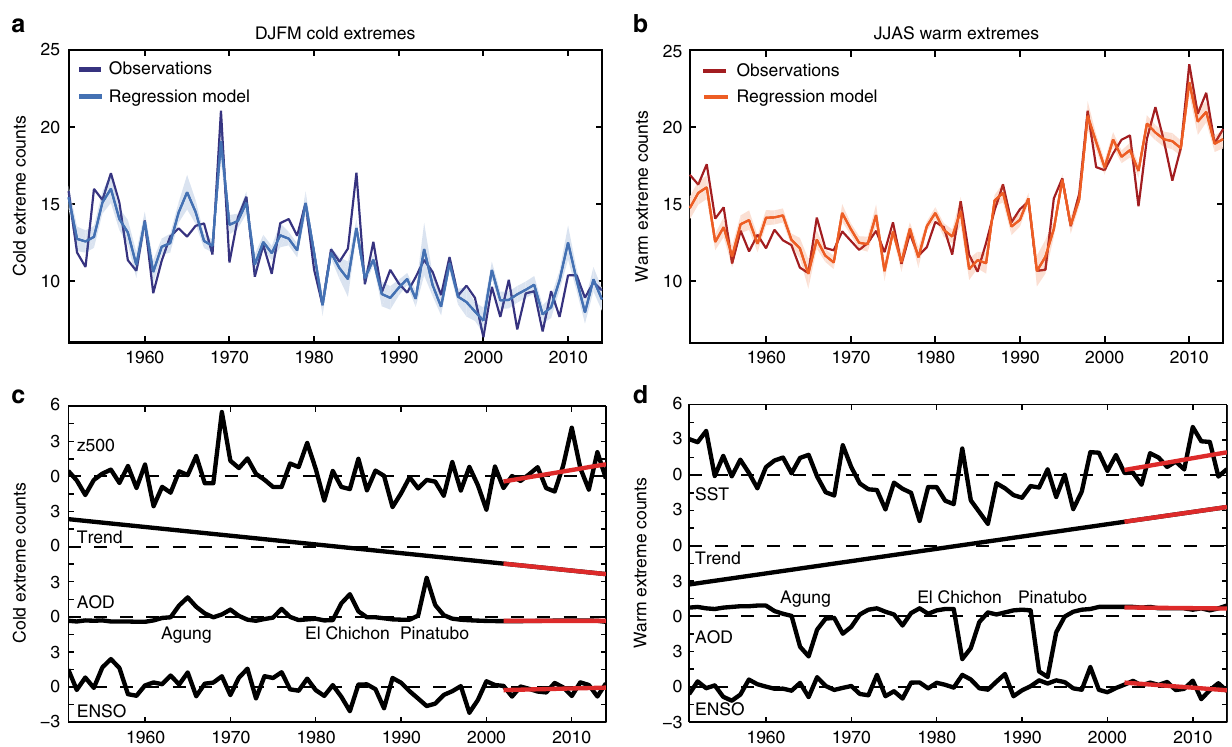
Fig. 2 Linear regressions of wintertime cold and summertime warm extremes. Time series of wintertime cold ( a ) and summertime warm ( b ) extreme temperature occurrences ( d season − 1 ) over Northern Hemisphere land from 1951 – 2014 in observations (dark blue and red) and for linear regression models with four predictors (light blue and orange). Shading indicates the 95% con fi dence interval for the regression. c , d Contribution of each individual predictor for the frequency of cold extreme ( c ) and warm extremes ( d ), calculated by multiplying the predictors by their corresponding regression coef fi cients. Red lines indicate linear trend lines for the hiatus period (2002 – 2014). Major volcanic eruptions are labeled in the AOD contribution plots. The top regressions in ( c ) and ( d ) indicate the in fl uence of the z500 and SST extremes patterns,